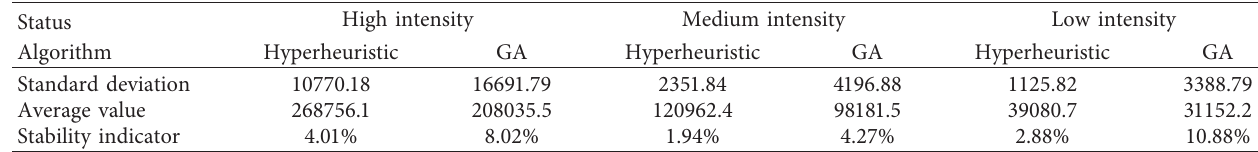
Figure 9: Result curve of GA and hyperheuristic algorithm of decreasing passenger flow. (a) High-intensity passenger flow. (b) Medium- intensity passenger flow. (c) Low-intensity passenger flow. Table 6: Stability analysis table of GA and hyperheuristic algorithm under decreasing passenger flow.